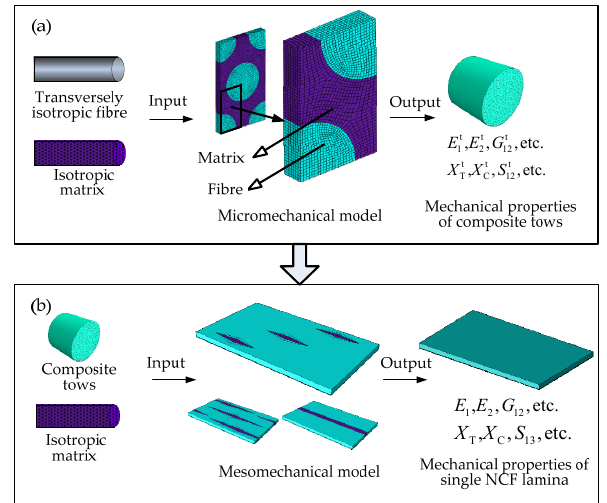
Figure 4. The workflow of multiscale analysis: ( a ) microscale; and ( b ) mesoscale.